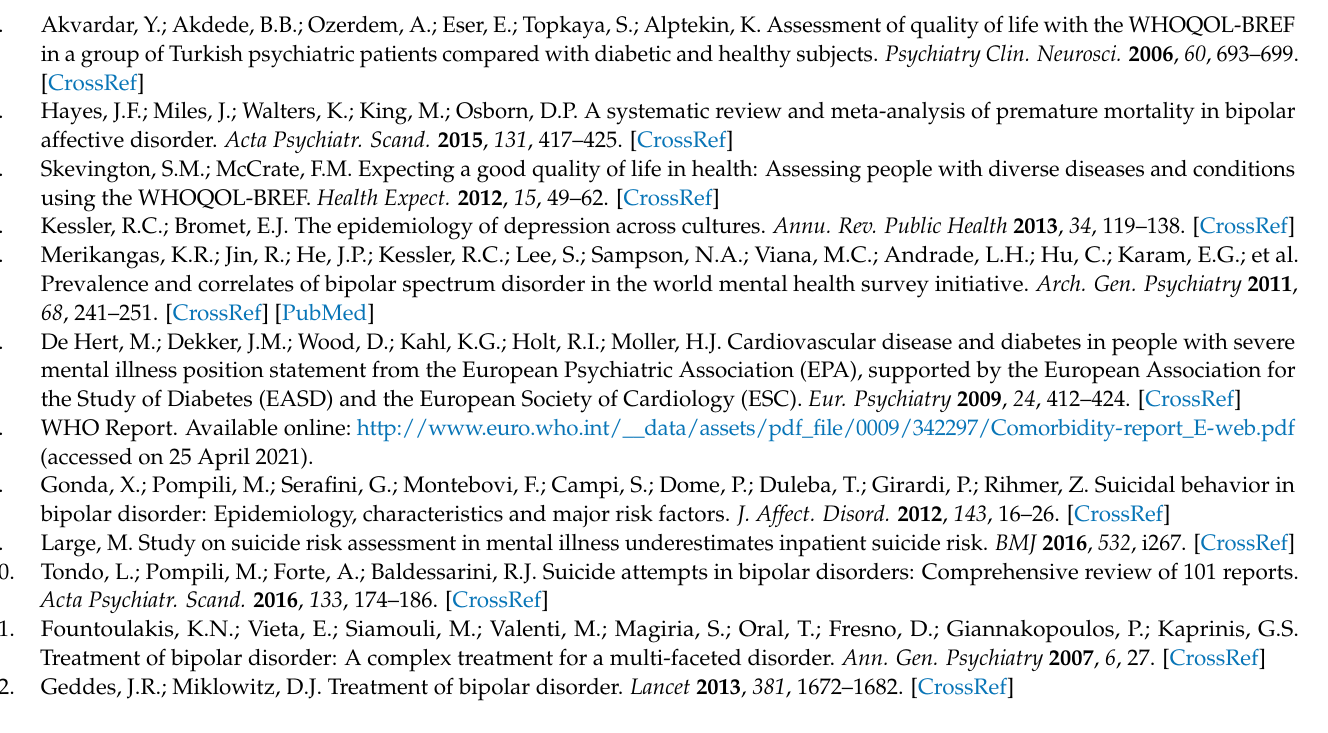
Table S3: Comparison of LTL between responders and non-responders to ECT in patients with TRD stratified based on intake of clonazepam; Table S4: Assessment of overrepresentation between SNPs and genes associated with response to ECT and LTL; Table S5: Association between SNP previously associated with LTL and response to